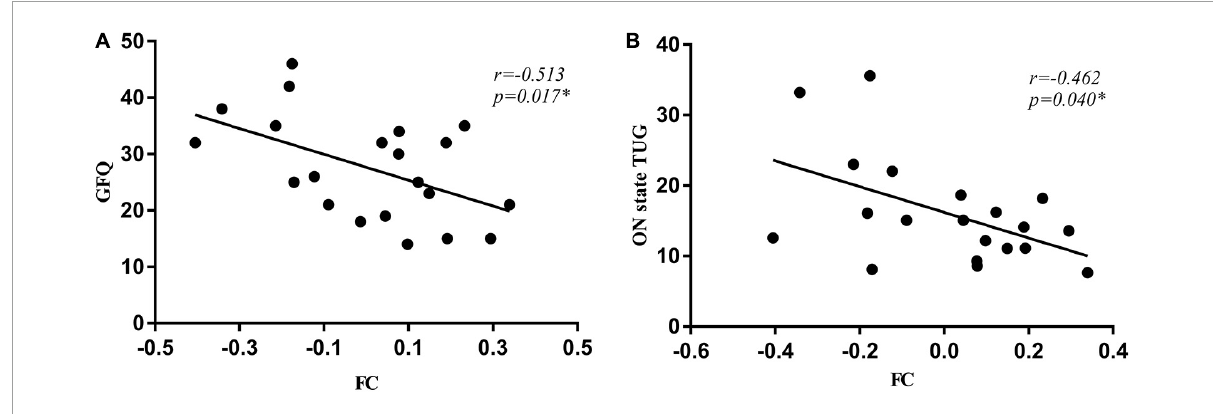
FIGURE4 The connectivity between right GPi and left middle occipital gyrus was negatively correlated with the GFQ score (A) as well as times of ON state TUG (B) . GFQ, Gait and Falling Questionnaire; TUG, Timed Up and Go